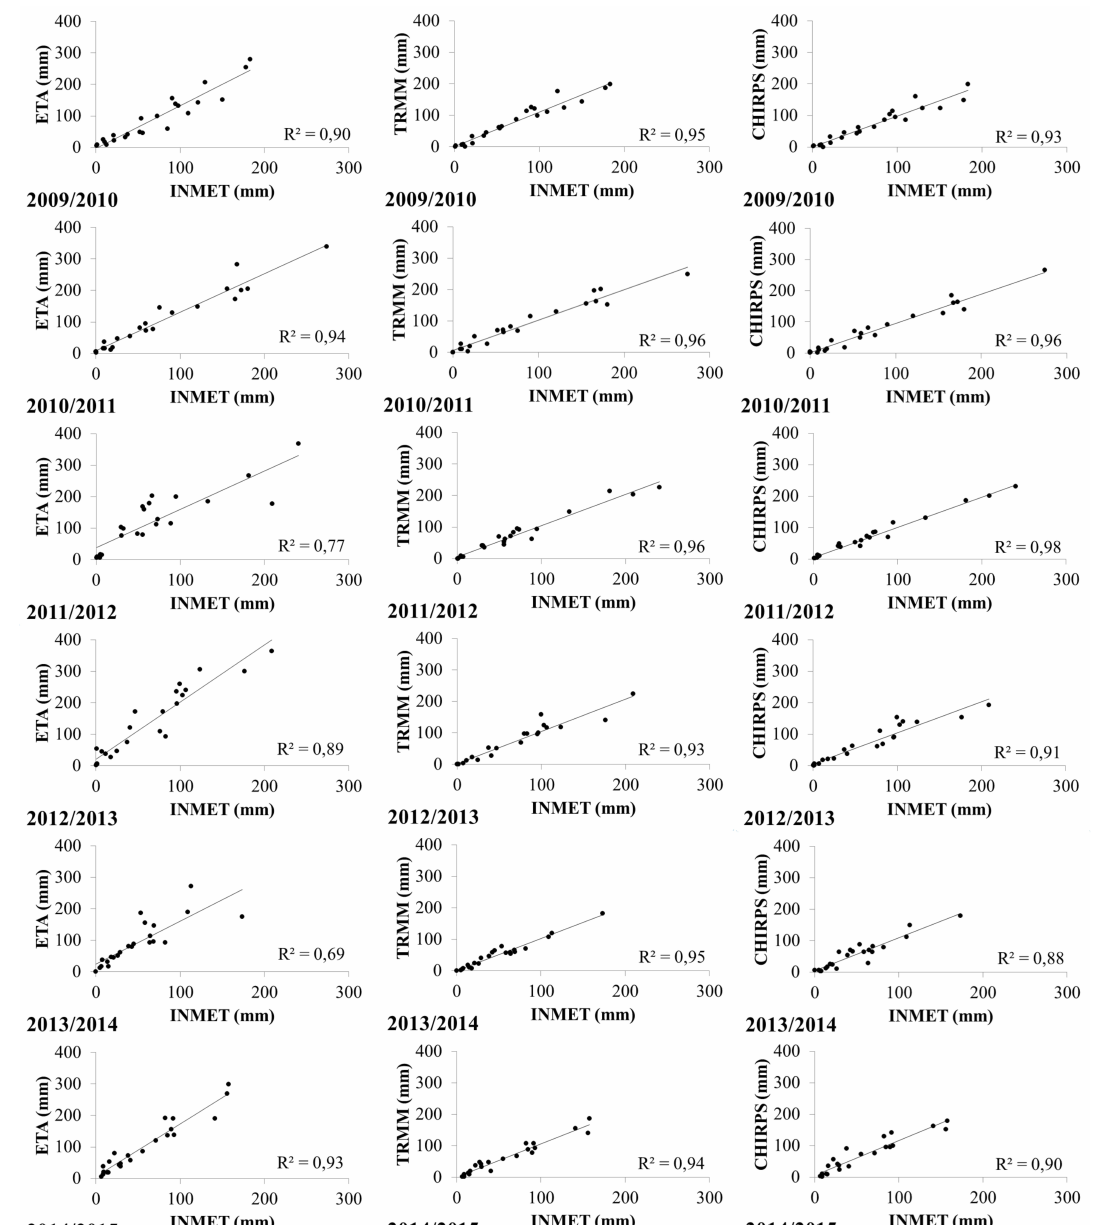
Figure 3. Precipitation (mm) from INMET versus the precipitation estimates from Eta, TRMM, and CHIRPS, per crop